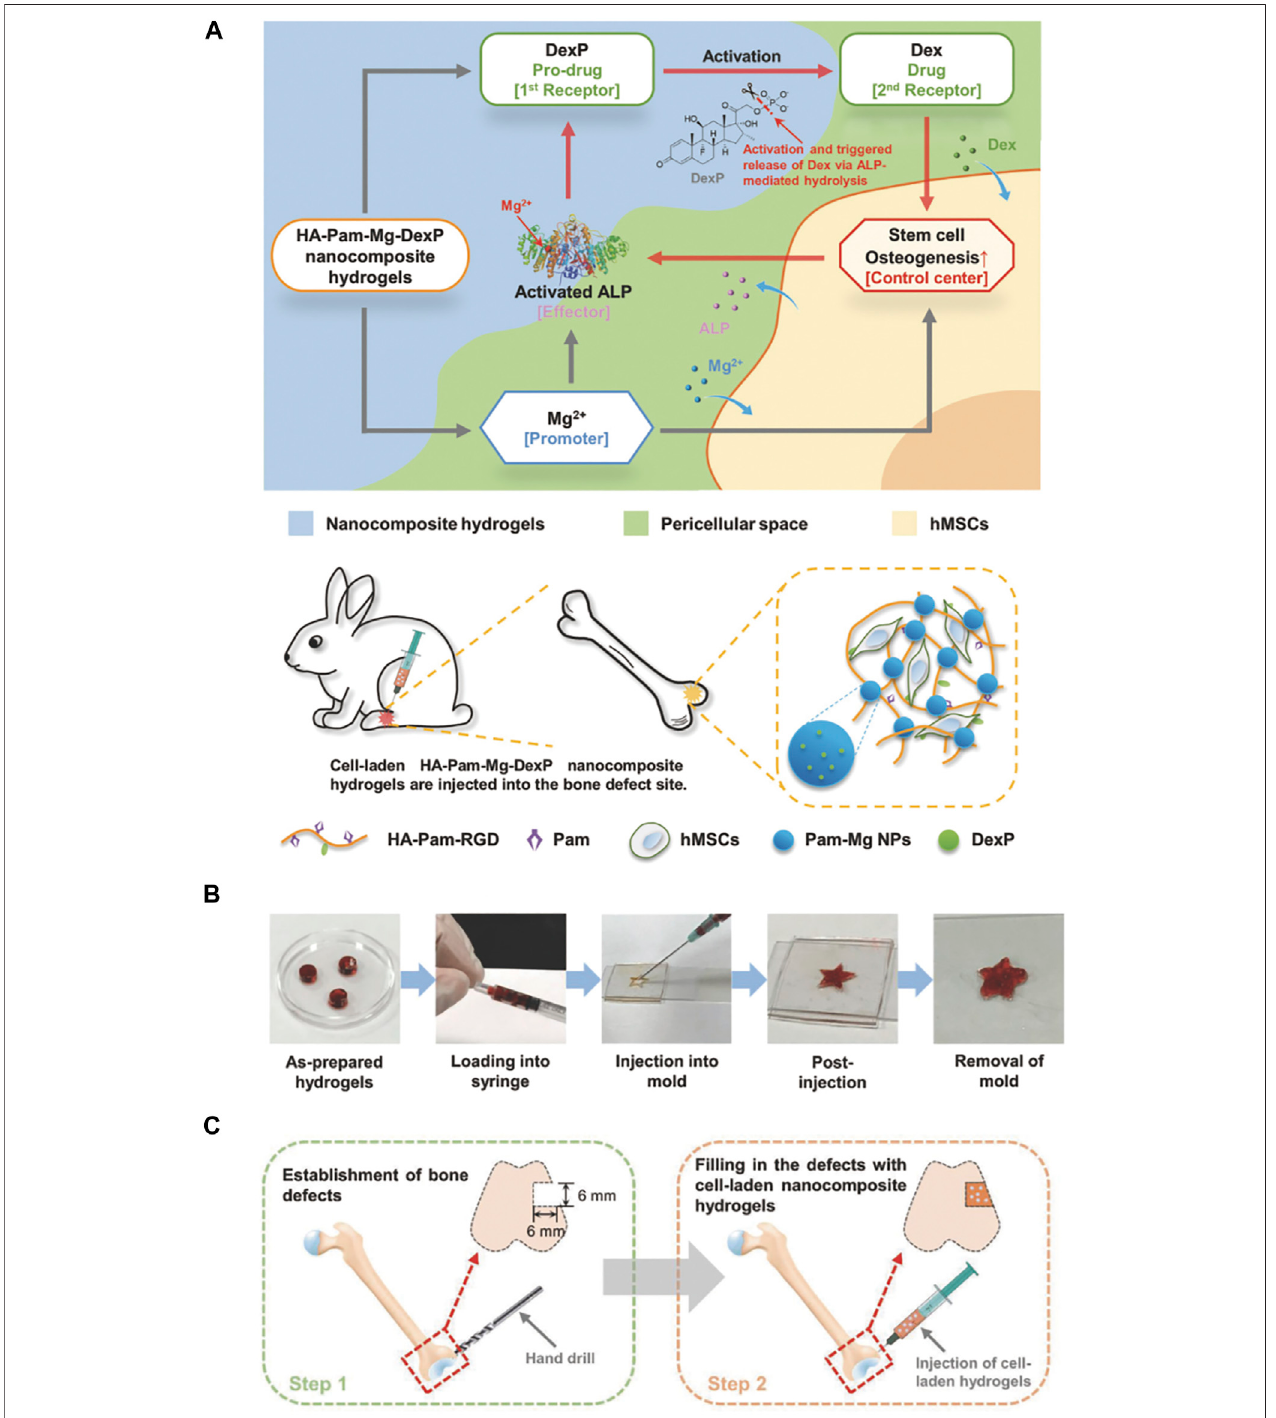
FIGURE 2 | Injectable HA-Pam-Mg nanocomposite hydrogel promotes the healing of bone defects. (A) Schematic representation of “ smart ” hydrogels and injections of hMSC-laden nanocomposite hydrogels promote in situ bone regeneration. (B) Demonstration of the injectability and formability of nanocomposite hydrogels. (C) HA-Pam-MgnanocompositehydrogelsencapsulatingMSCspromotehealingofrabbitfemurdefects(Zhangetal.,2018b).Copyright2018,WILEY-VCH Verlag GmbH & Co. KGaA, Weinheim.